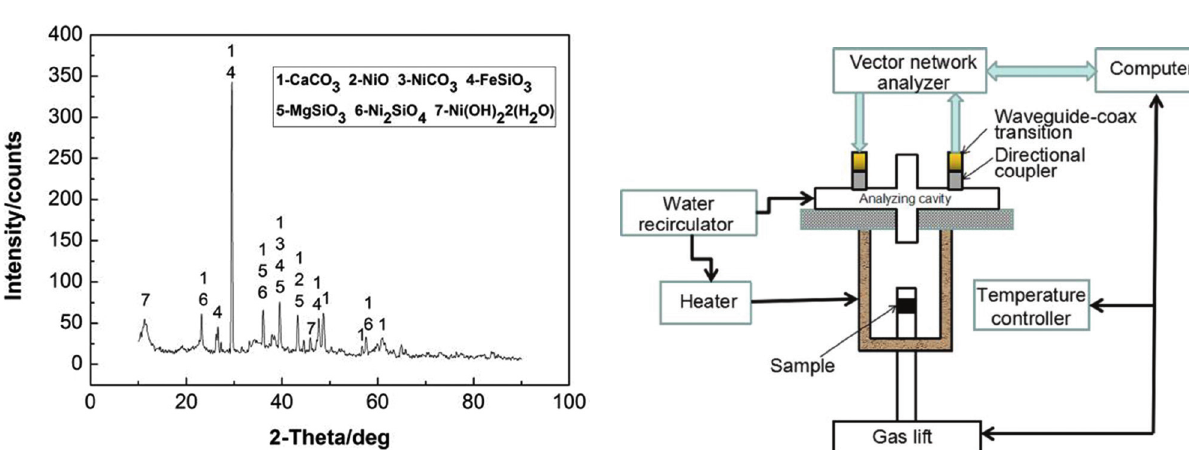
Figure 2: Schematics of the permittivity measurement system. Figure 1: XRD pattern of the raw material.